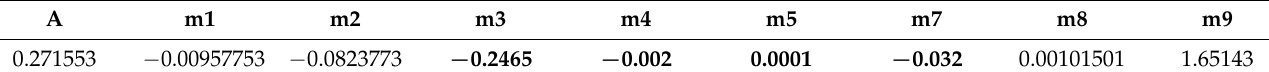
Table 2. Coefficients of Equation (4) used to determine σ p values of the 5019 aluminium alloy (Variant 2) [45,46].